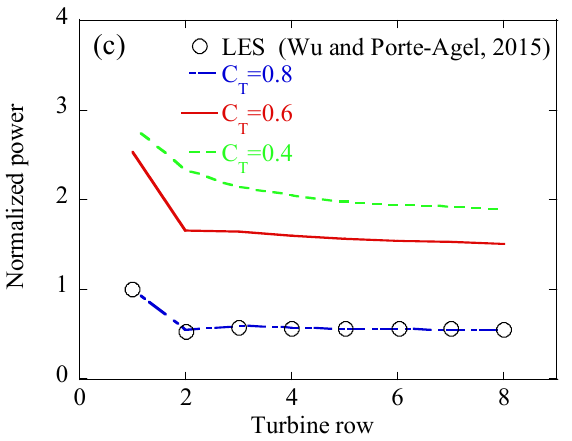
Figure 13. Effect of ambient turbulence intensity on: ( a ) wind velocity; ( b ) turbulence intensity; ( c ) wind power generation of wind turbines in a row.